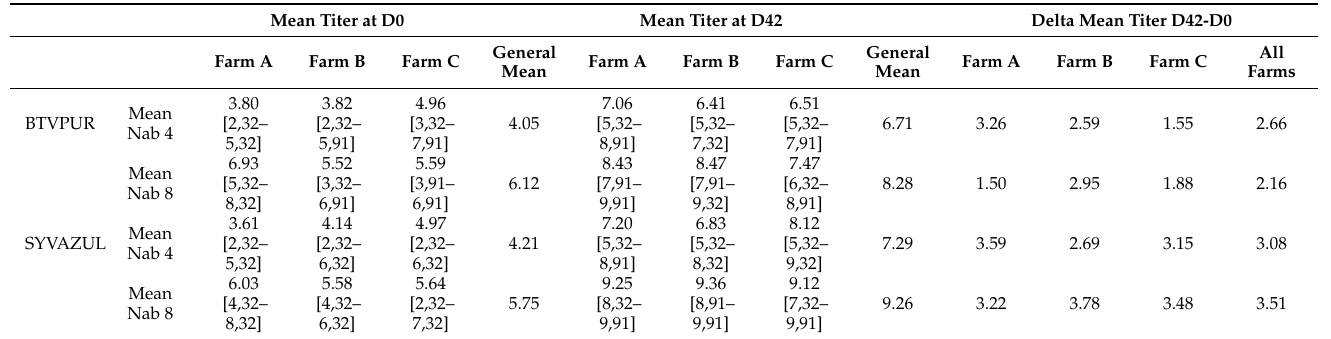
Table 3. Average serum-neutralizing antibody (Nab) titer per farm and per serotype and difference between the average titers at D42 and D0 according to the vaccine used for boosting.